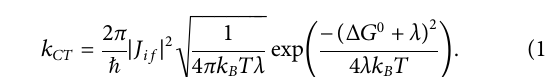
Frontiers in Materials |